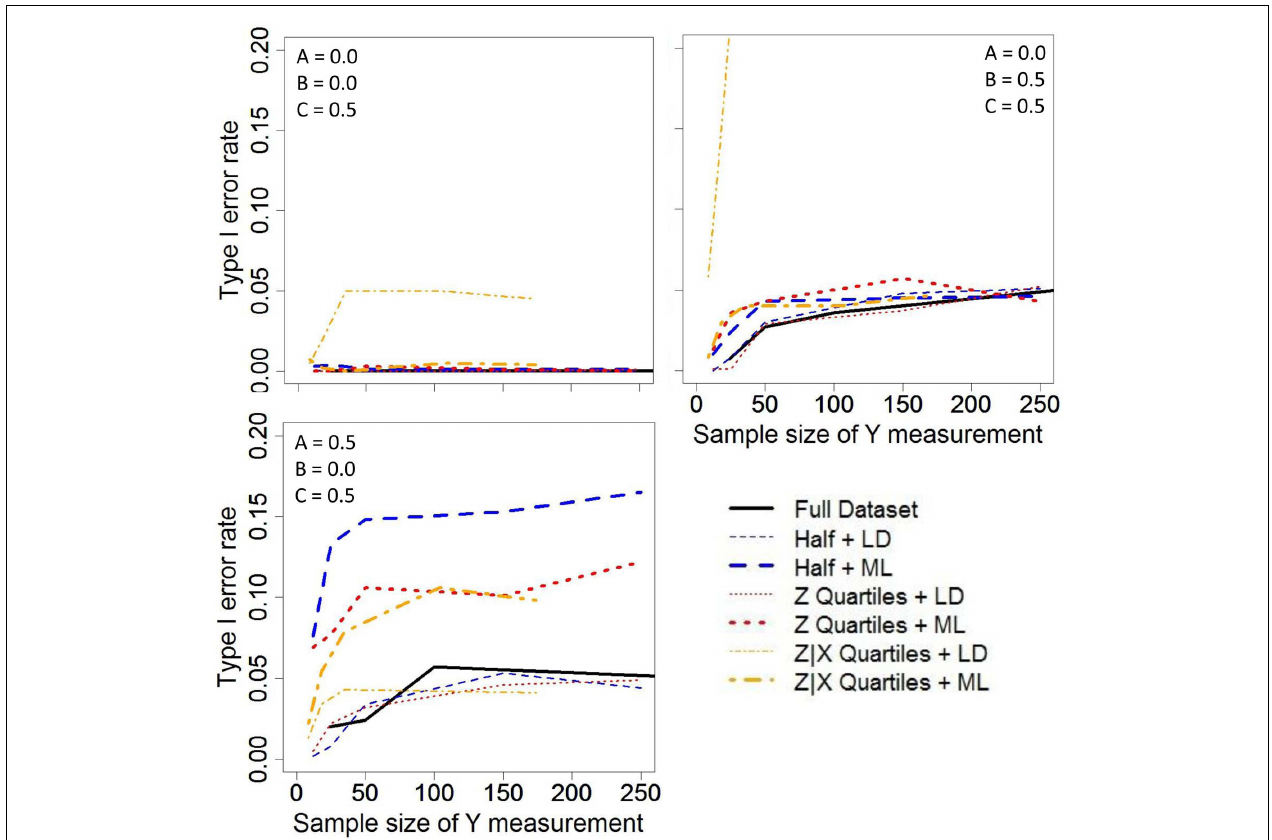
FIGURE 2 |Type I error rates for the various sampling strategies across different correlation structures. Sampling strategies with listwise deletion (LD) are represented with thin lines while maximum likelihood estimates are thick lines.